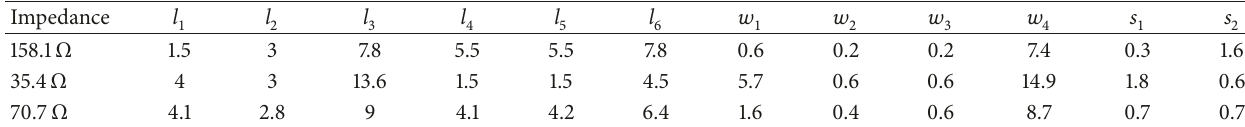
Table 2: Dimensions of ATLs of proposed power divider (unit: mm).